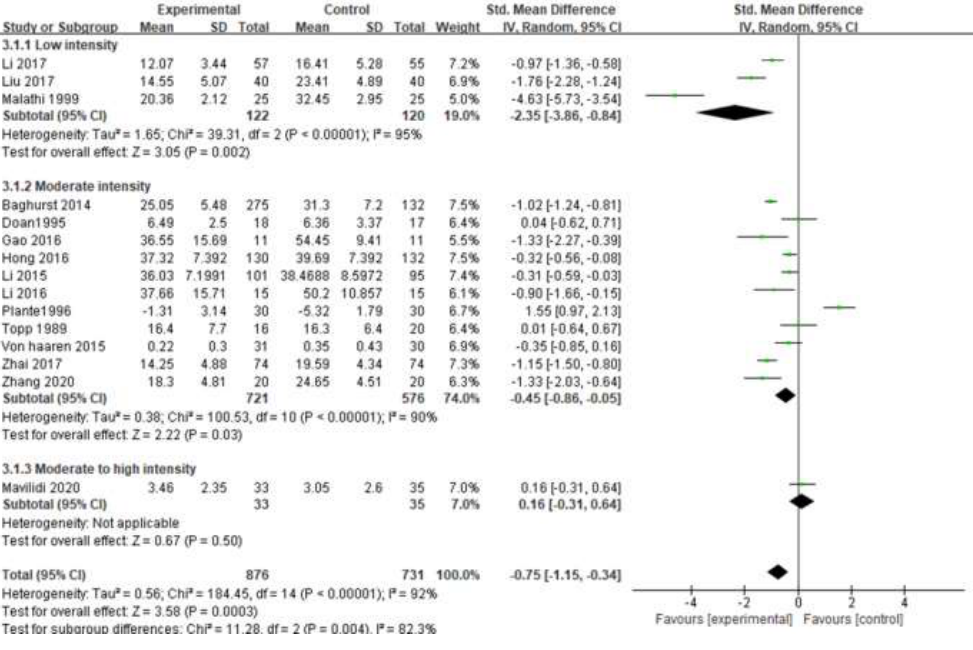
Figure 6. Subgroup analysis of exercise intensity [17–20,22–32].